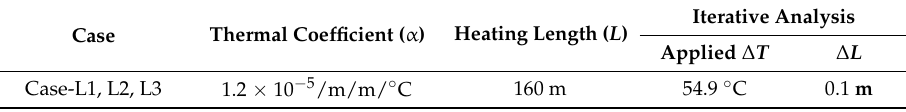
Figure 6. Heating regions for the verification example bridge. Table 6. Applied temperature rises ( ∆ T ) and heating lengths ( L